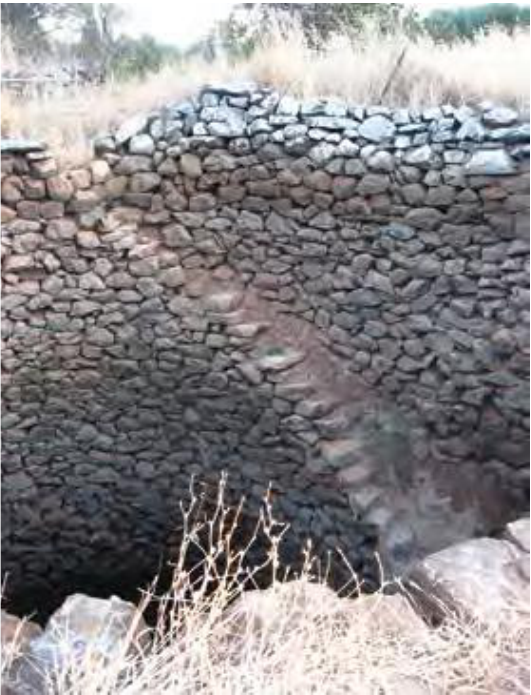
Figure 14. A cistern near Neapolis in eastern Crete which is still in use (photo: A. N. Angelakis)